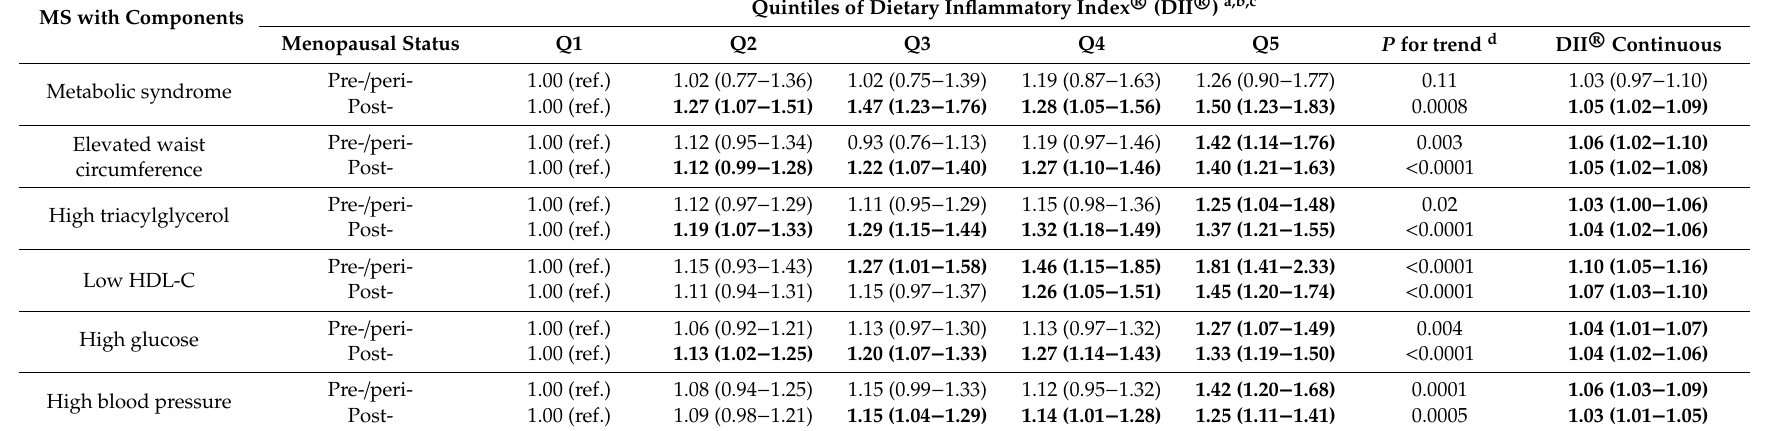
Table 3. Hazard ratios (HRs) and 95% confidence intervals (CIs) for risk of metabolic syndrome and its components as stratified by menopausal status of women according to DII ®